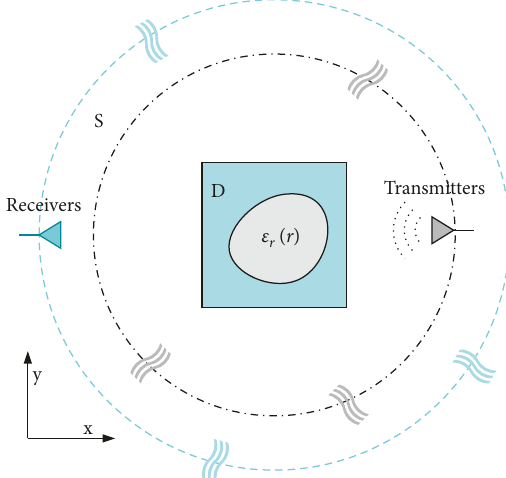
Figure 1: The configuration of the electromagnetic inverse